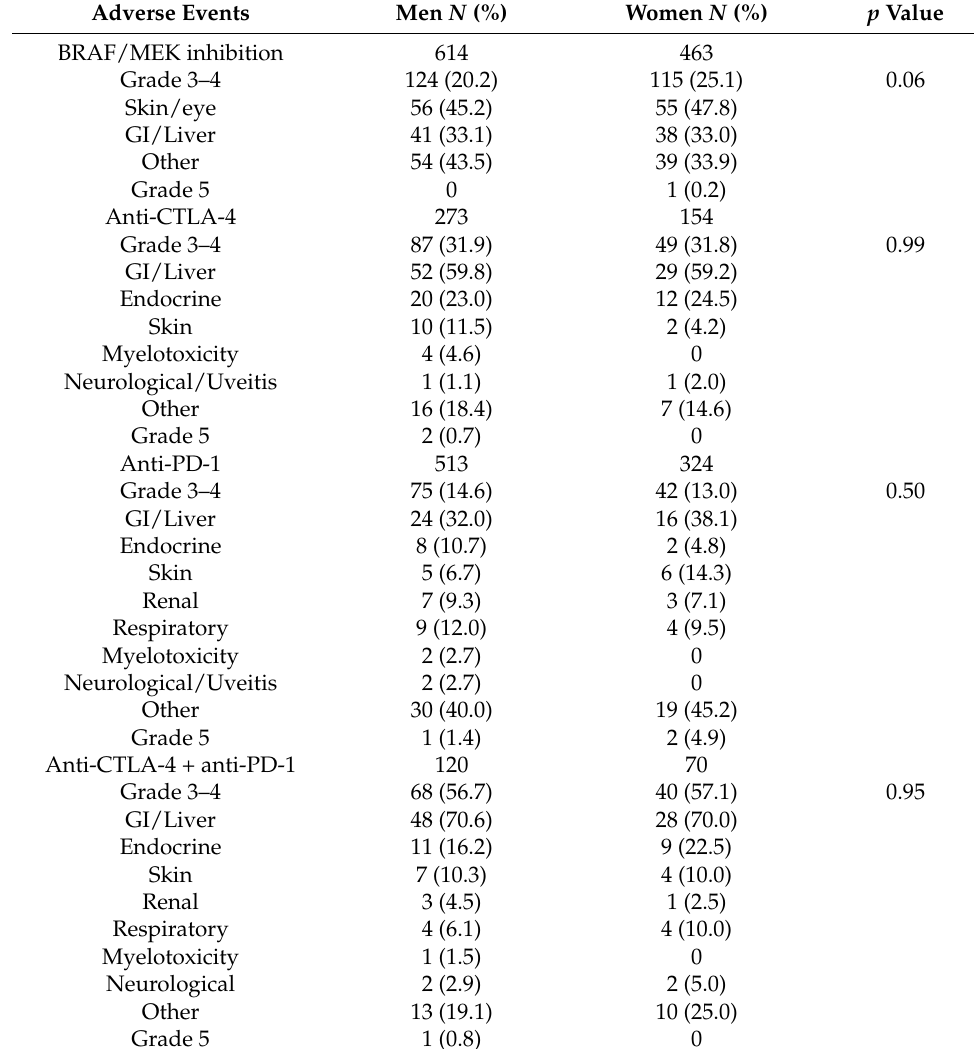
Table 2. Adverse events following systemic